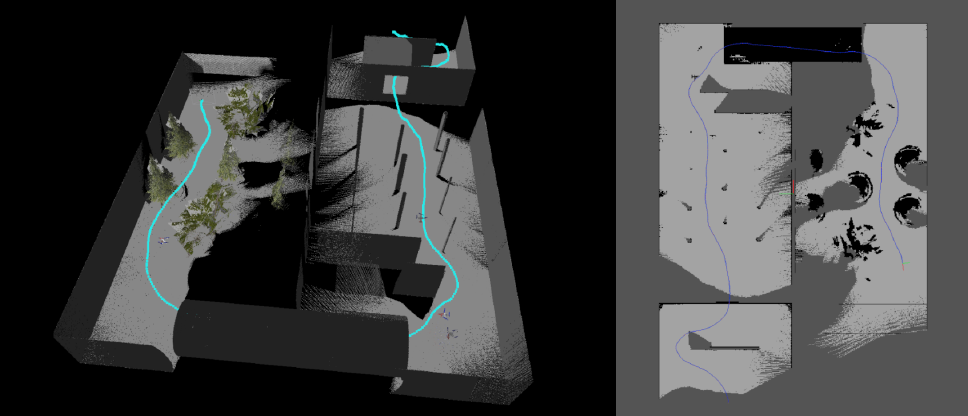
Figure 22. Visualization of the trajectory of UAV controlled by the SCAN algorithm (Area 1, Area 2, and Area 3).